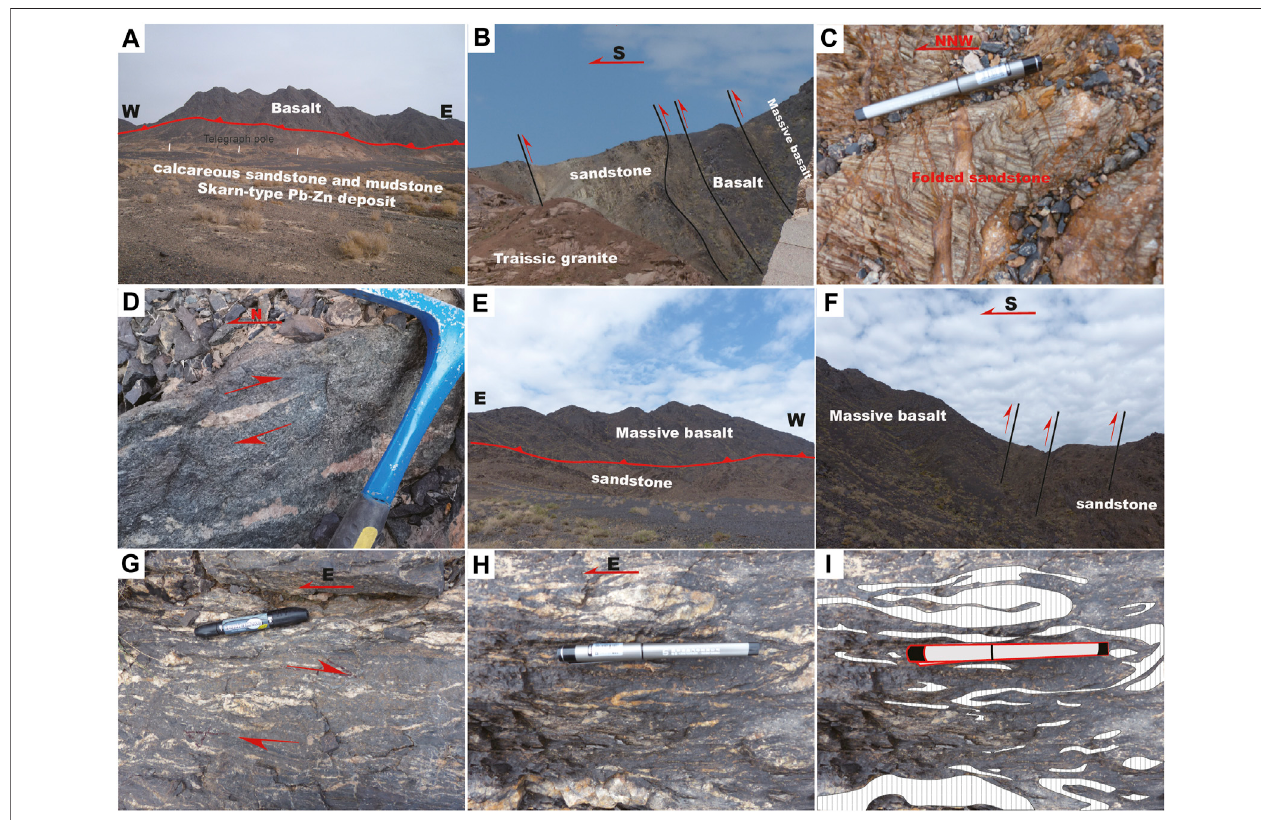
FIGURE 5 | Structural deformation photos for different rocks of the Huaniushan complex, Beishan. (A) Huaniushan complex thrust on Huaniushan Formation (O 2 hn ) in the southern part; (B) section of the thrust in the southern part; (C) folded sediments in the southern part; (D) deformed gabbro blocks in the Huaniushan complex; (F) Huaniushan complex thrust on sediments in the northern part; (G) section of the thrust in the northern part; (H) strongly deformed and silici fi ed basalt and suggest the dextral shear; (I) strongly deformed, folded, and silici fi ed basalt.